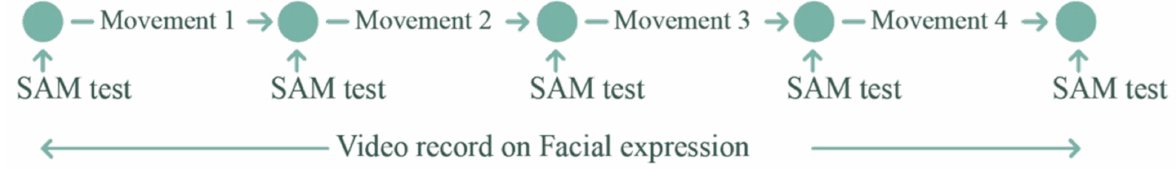
Figure 6. SAM tests that were used in the experiment